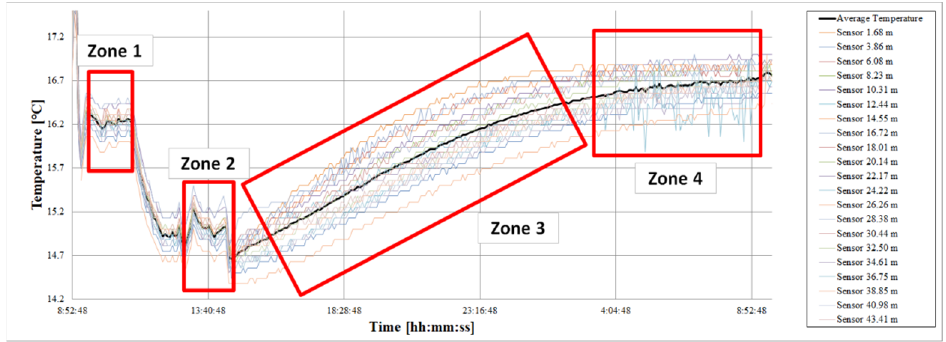
Figure 19. Graphic representation of the four stable zones detected during the sensor calibration process.